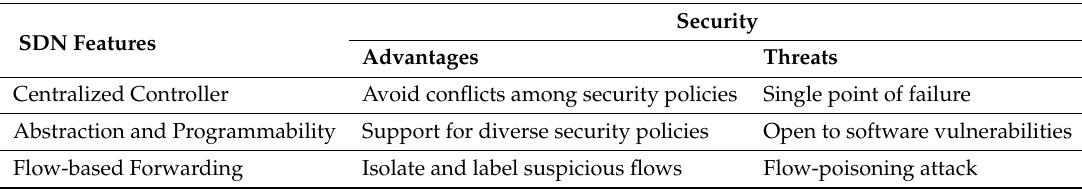
Table 2. SDN: Security vulnerabilities and